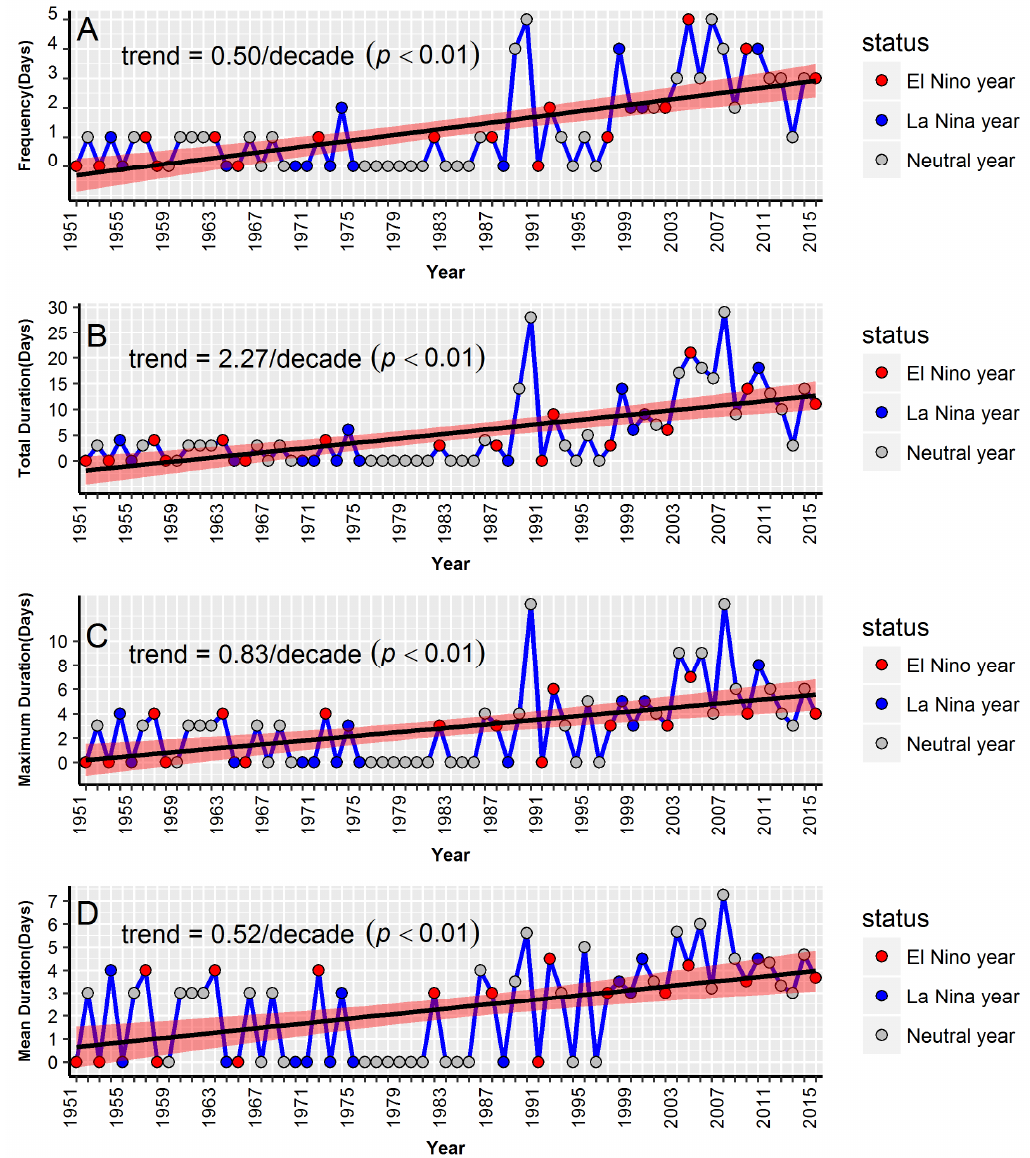
Figure 3. Annual time series of frequency and duration of heat waves in Guangzhou during 1951–2015. ( A ) Frequency; ( B ) total duration; ( C ) maximum duration and ( D ) mean duration. The linear trend line (black line) and the corresponding 95% confidence intervals (the shaded areas) are also shown. The solid dots in different colors show the occurrence of El Niño years, La Niña years and Neutral years.